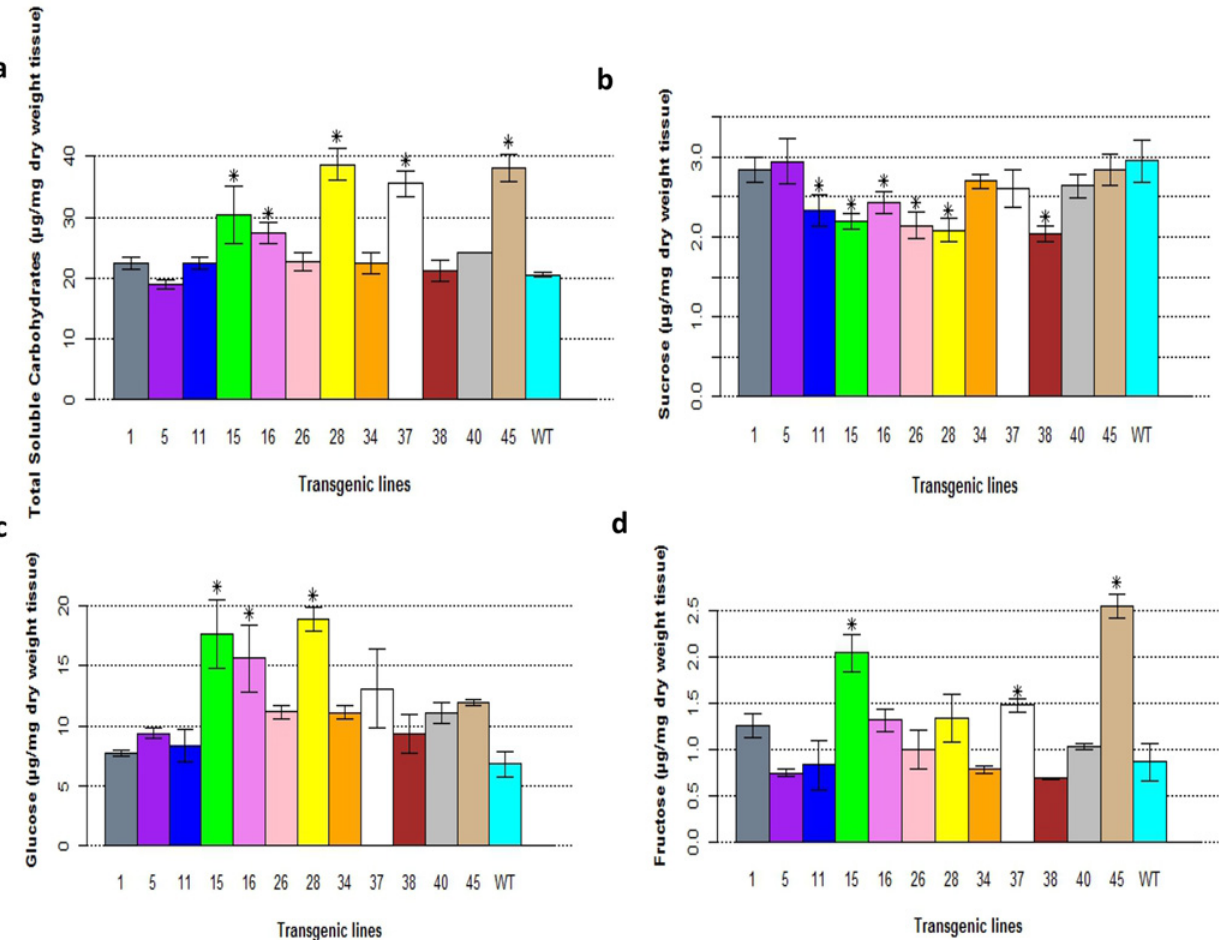
Fig 6. Changes in carbohydrates (sugars) in PsnSusy2 tobacco transgenics. a. Total soluble sugar contents of stem tissues in different PsnSuSy2 tobacco transgenic lines. b. Sucrose contents of stem tissues in different PsnSuSy2 tobacco transgenic lines. c. Glucose contents of stem tissues in different PsnSuSy2 tobacco transgenic lines. d. Fructose contents of stem tissue in different PsnSuSy2 tobacco transgenic lines. All samples in 6a, 6b and 6c were harvested from tissues between PI3 and PI5. All measurements shown in 6a-d were averaged from five different samples per line ± S.E. The t -test was used to examine the significance of difference between PsnSusy2 transgenic and wildtype lines, and * denotes significance at p < 0.05. The WT represents wildtype tobacco while the others lines labeled with line numbers are of different PsnSusy2 tobacco transgenic lines. Note that the total soluble sugar contents were measured using two-month-old plants, whereas sucrose, glucose, and fructose were measured one week